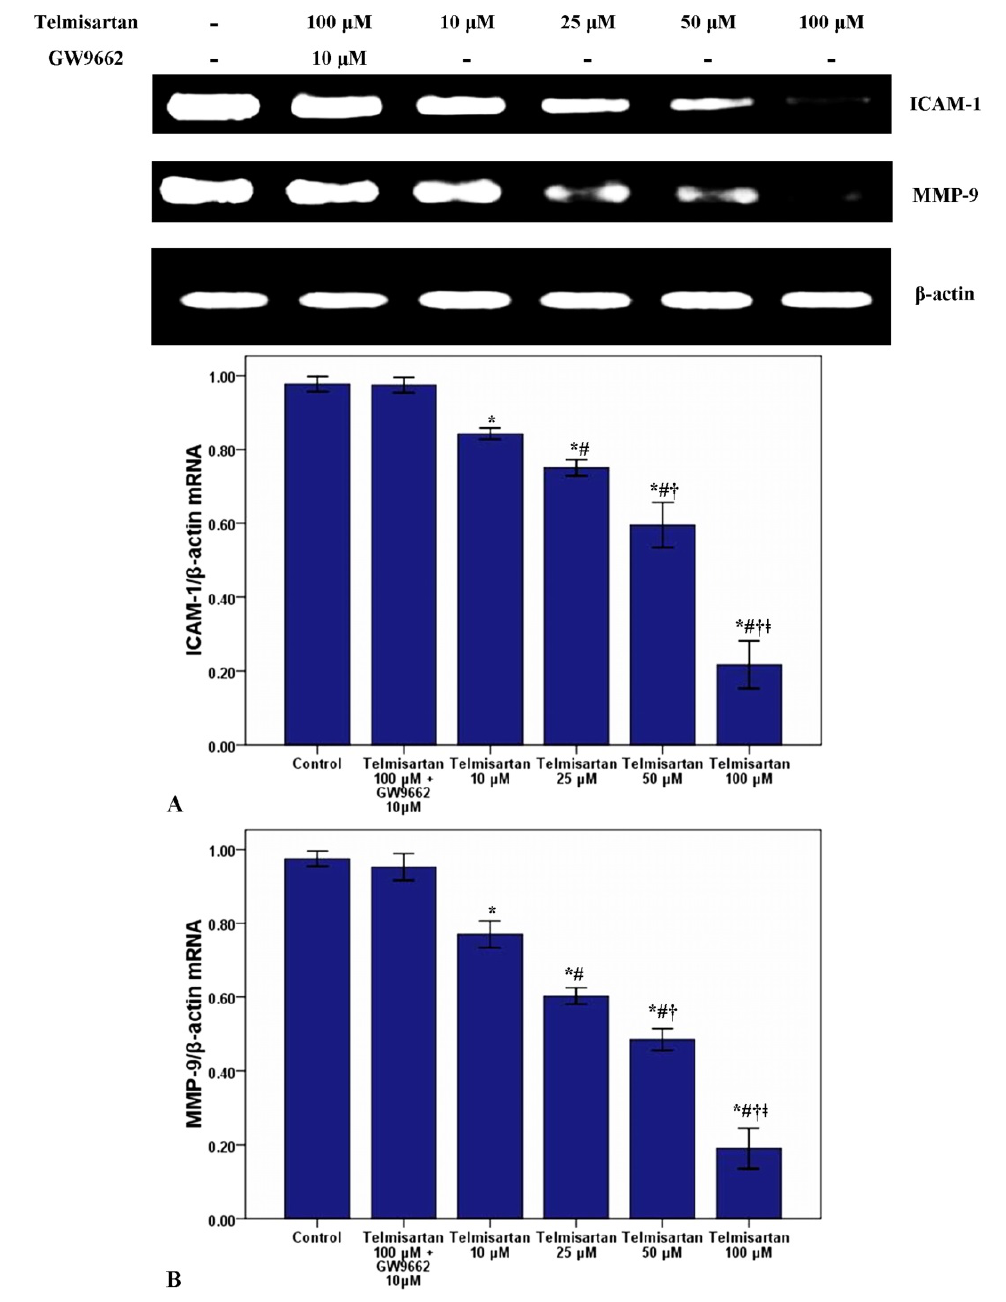
Figure 3. Telmisartan reduces the mRNA expression of ICAM-1 and MMP-9 in A549 cells. The mRNA expression of ICAM-1 (A) and MMP-9 (B) in A549 cells treated with 4 concentrations of telmisartan (10, 25, 50 and 100 μ M) or GW9662 (10 μ M) for 48 h were measured. Quantitative data were presented as mean ± SD ( n = 4). * p < 0.05